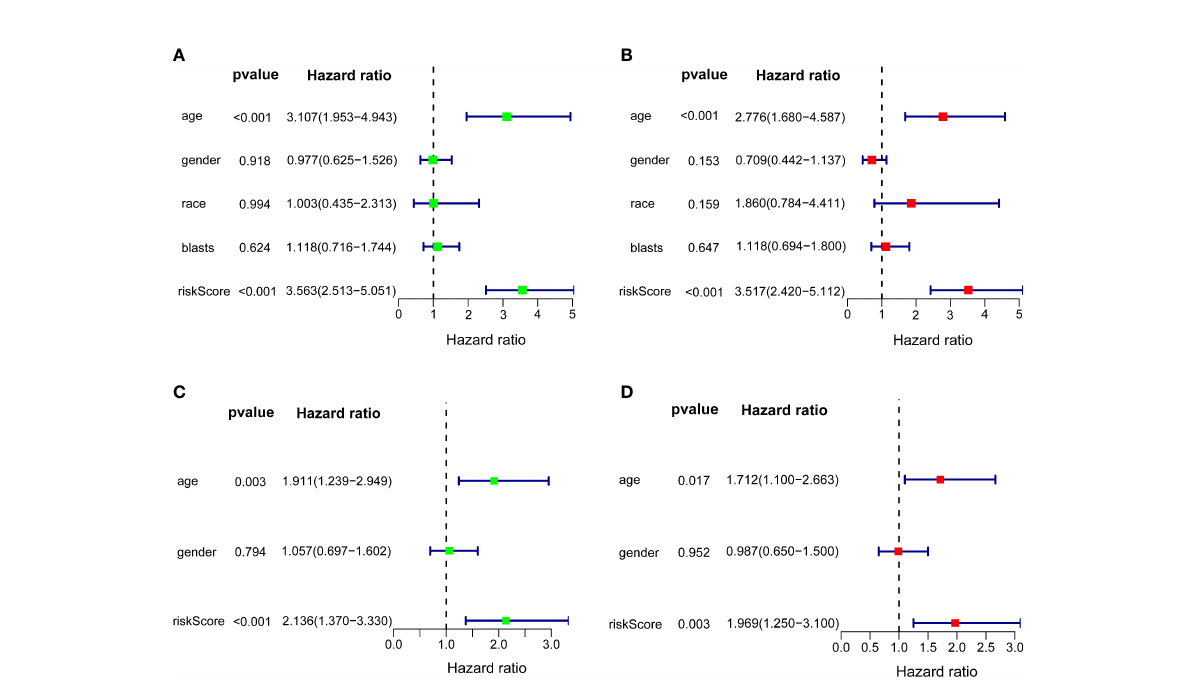
FIGURE 5 Independent prognostic value of the 10-gene signature. Forest plots of univariate cox regression analyses (A) and multivariate cox regression analyses (B) in TCGA cohort. Forest plots of univariate cox regression analyses (C) and multivariate cox regression analyses (D) in the ICGC cohort.